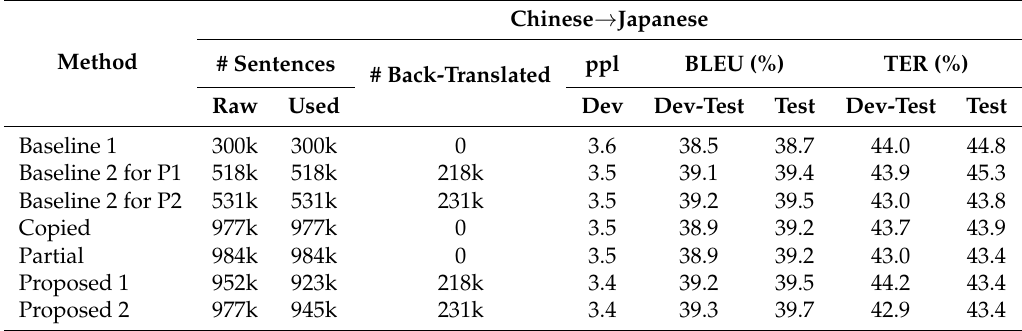
Table 4. Experiment results of Japanese → Chinese Machine Translation (MT) with 300k training data. “ppl” denotes perplexity. “Dev” denotes development data. “Dev-test” denotes development-test data.